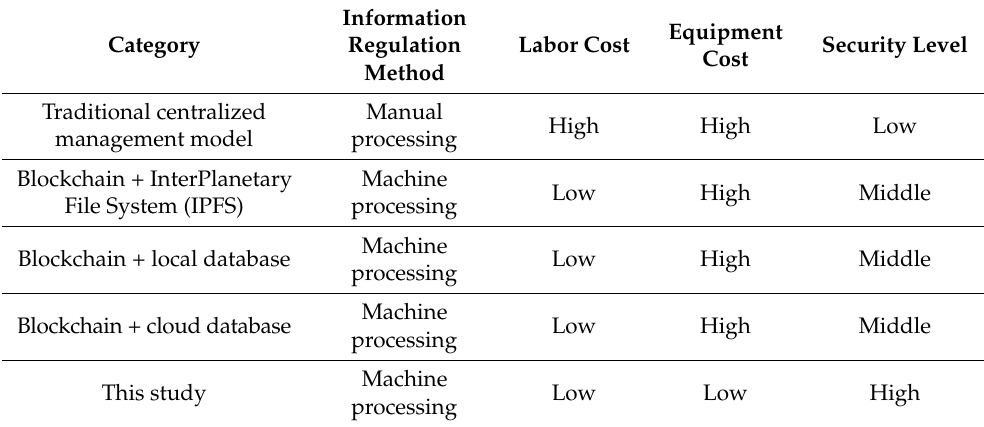
Table 6. Comparison of different blockchain application models in agricultural products and food information management. Category Traditional centralized management model Blockchain + InterPlanetary File System (IPFS) Blockchain + local database Blockchain + cloud database This study